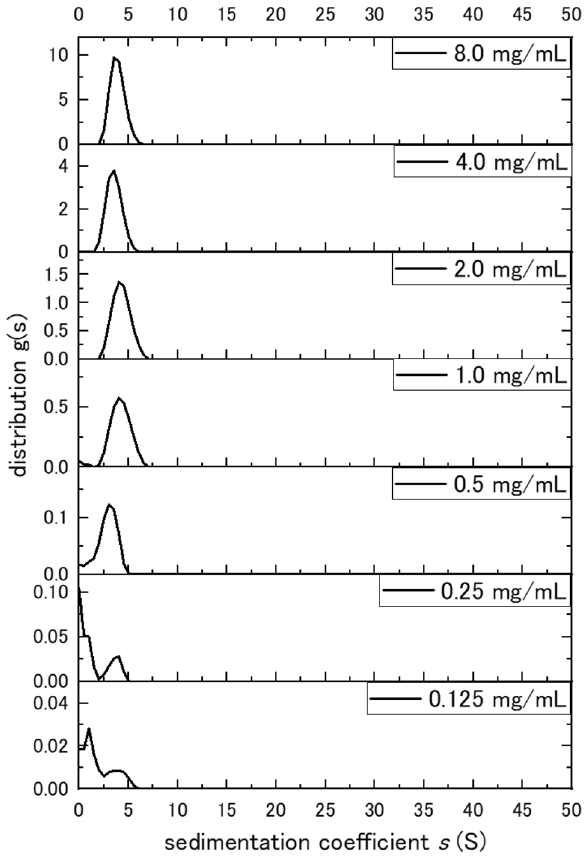
Figure 2. Sedimentation coefficient distribution of teicoplanin A2 at different concentrations from 0 to 5 mg/mL. The Y-axis ranges are different for each sample because that is clearer to see unimodality for higher concentrations (> 0.5 mg/mL) and separation occurring for lower concentrations (< 0.5 mg/mL).